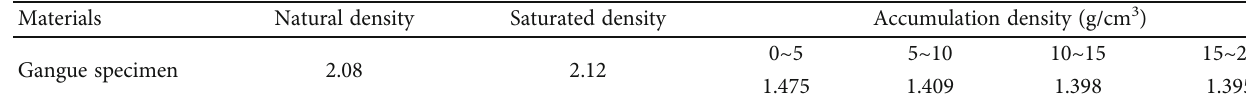
Figure 5: Illustration of the present testing process. Table 3: Densities of the gangue specimens with di ff erent sizes.